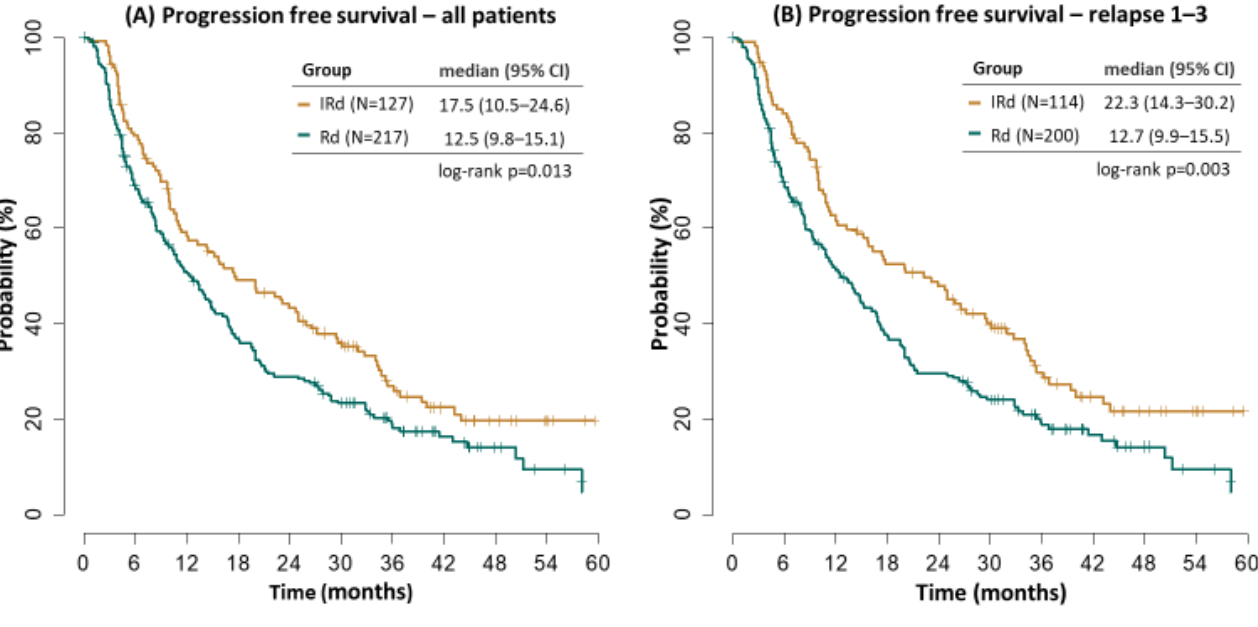
Figure 1. Progression free survival.